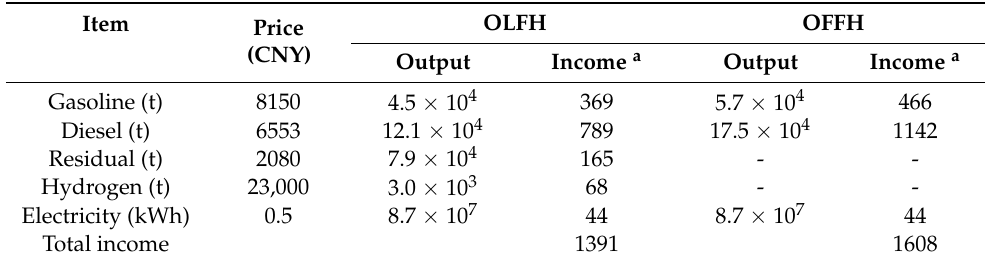
Table 6. Sales income for CLeSTL with different scenarios.